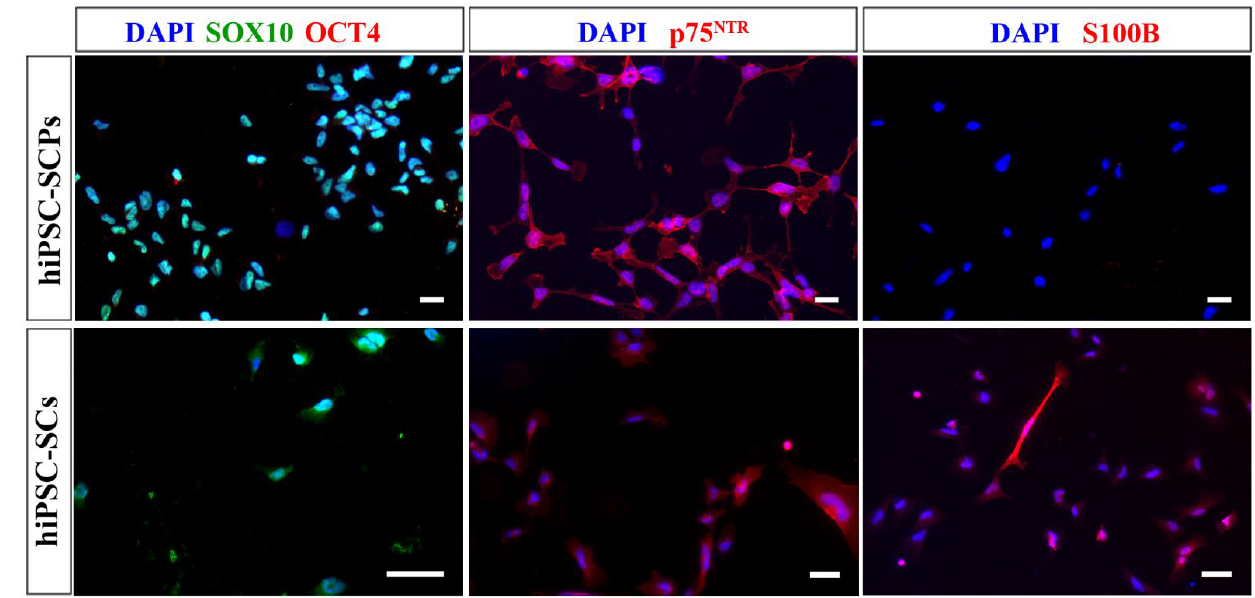
Figure 6. Immunocytochemistry images of UCL hiPSC-SCPs and hiPSC-SCs from low-density plated hiPSC-SCPs. Both cell types were positive for SOX10 (green) and p75 NTR (red). Only hiPSC-SCs were positive for S100B (red) while both were negative for OCT4 (red). DAPI was used to stain the nuclei (blue). Scale bar = 20 µm (hiPSC-SCPs), 50 µm (hiPSC-SCs). As the cells differentiated from hiPSCs to hiPSC-SCPs (Figure 7), the change from hiPSCs growing in colonies to more dispersed cells occured early on once the media was changed from Essential 8 Flex media to antibiotic free NDM and SCPDM (Figure 7B). Furthermore, the proportion of cells positive for OCT4 reduced while the number of SOX10 positive cells increased over time, reaching close to 100% at DIV 18 in SCPDM (Figure 7E,F).